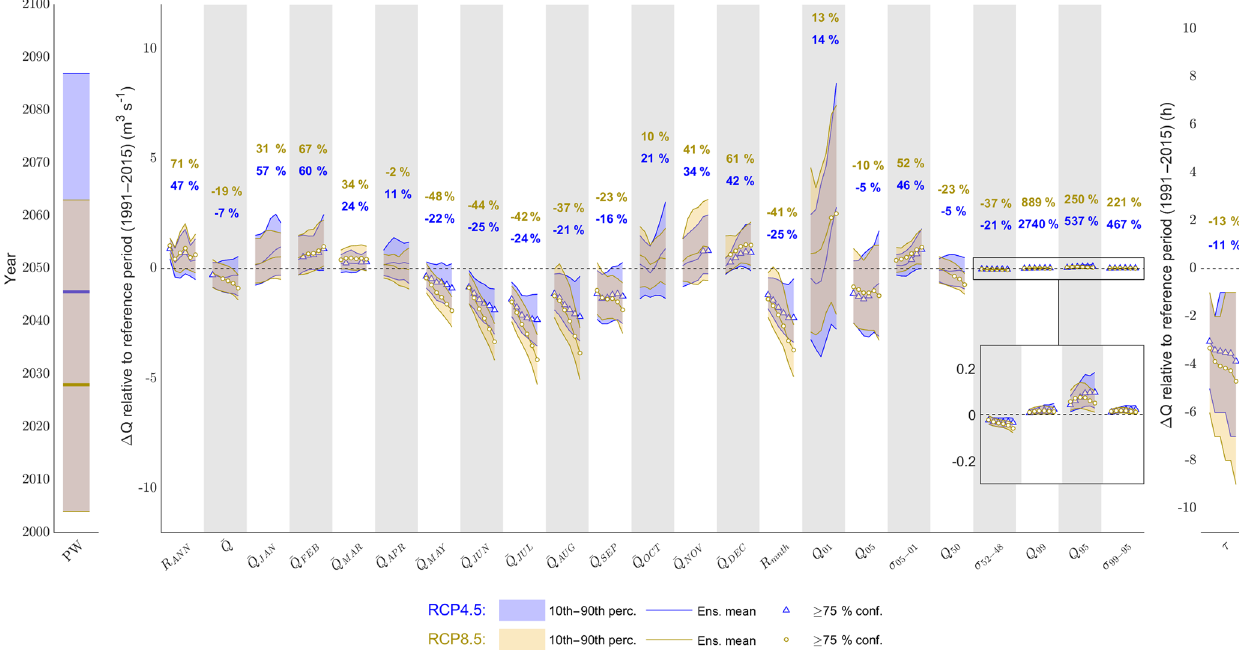
Figure 12. Projected changes in river discharge signatures. For each signature, the trajectory of the ensemble mean change over the 21st century time slices (2030s to 2080s) relative to the reference period (1991–2015) is shown by the solid coloured lines. These lines are marked for each time slice where there is ≥ 75% confidence in the direction of change. They are bounded by the 10th and 90th percentiles of the projections (bands). Also shown are 2080s ensemble mean change expressed as a percentage of simulated signatures for the reference period (text). Note that the peak water (PW) signature is not expressed as a change but as the overall raw projections. Table 2. Top five river discharge signatures ranked according to the average effect size for each of the main effects, interactions, and remaining error on projected changes for the 2030s and 2080s. Effect sizes are included in